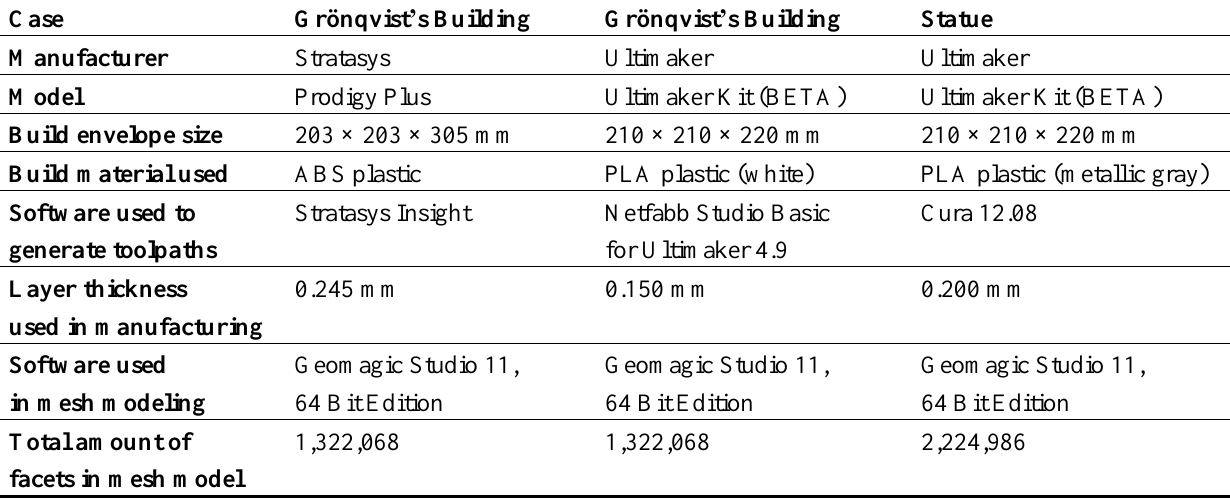
Table 1. Specifications of the rapid prototyping machines